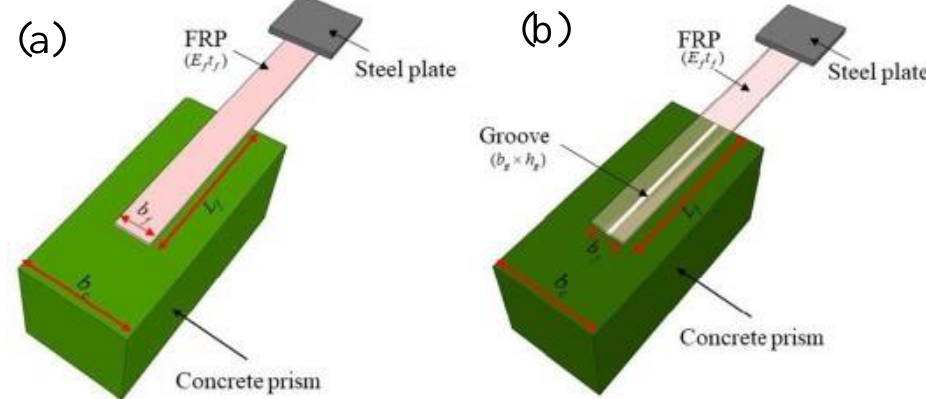
Figure 1. Single-lap shear test: ( a ) FRP externally bonded on concrete; ( b ) FRP externally bonded on the grooves of concrete (Reprinted/Adapted with permission from Su et al. [43]).